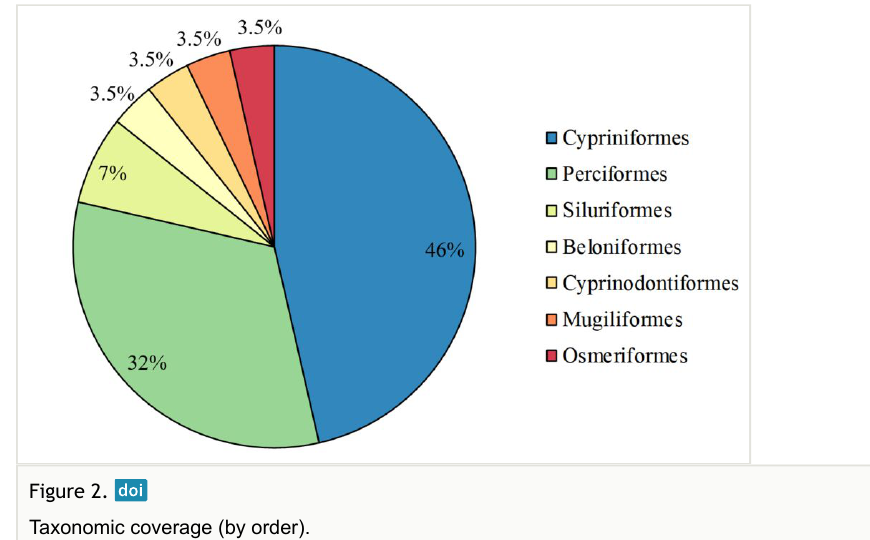
Figure 2. Taxonomic coverage (by